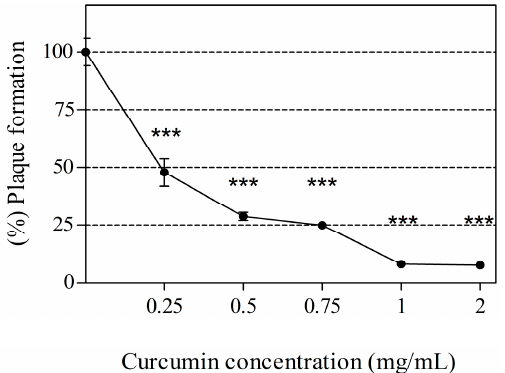
Figure 2. Anti-noroviral effect of curcumin (CCM) at various concentrations in RAW 264.7 cells. MNV was mixed with 0.25, 0.5, 0.75, 1 or 2 mg/mL CCM and stored 72 h at 4 °C. Virus titers were measured by plaque assay and percentage was compared to a vehicle control (DMSO treated).